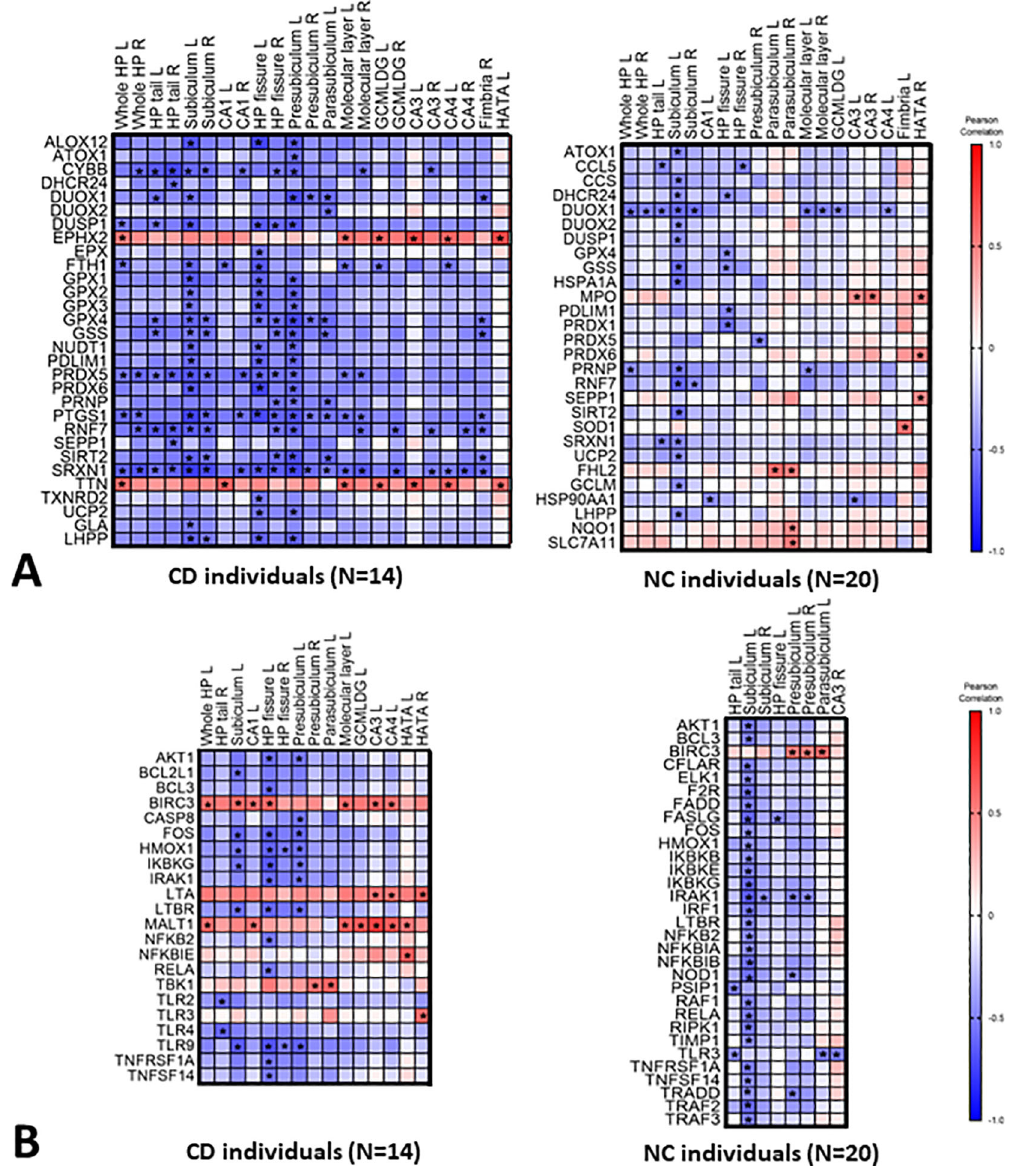
Figure2.Correlationheatmapsbetween(A)theredoxgenesbloodlevelsandhippocampalsegmentsvolume; (B) the inflammatory genes blood levels and hippocampal segments volume. On the right panel are